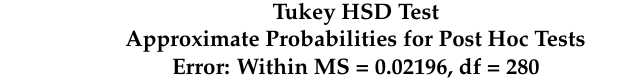
Table 4. Tukey HSD test results for pairs of elevation data.